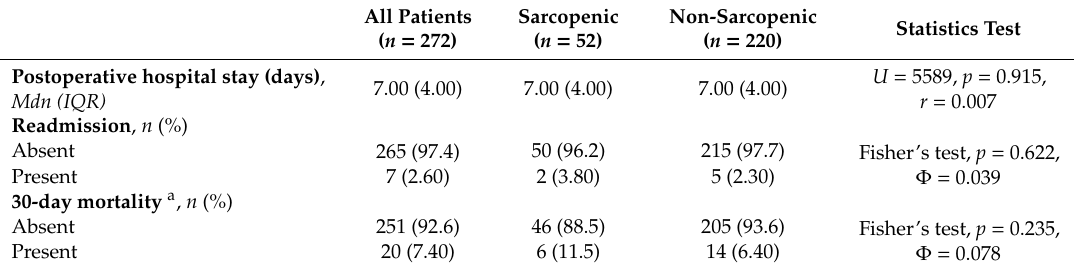
Table 5. Relationship between sarcopenia and other postoperative morbimortality outcomes.